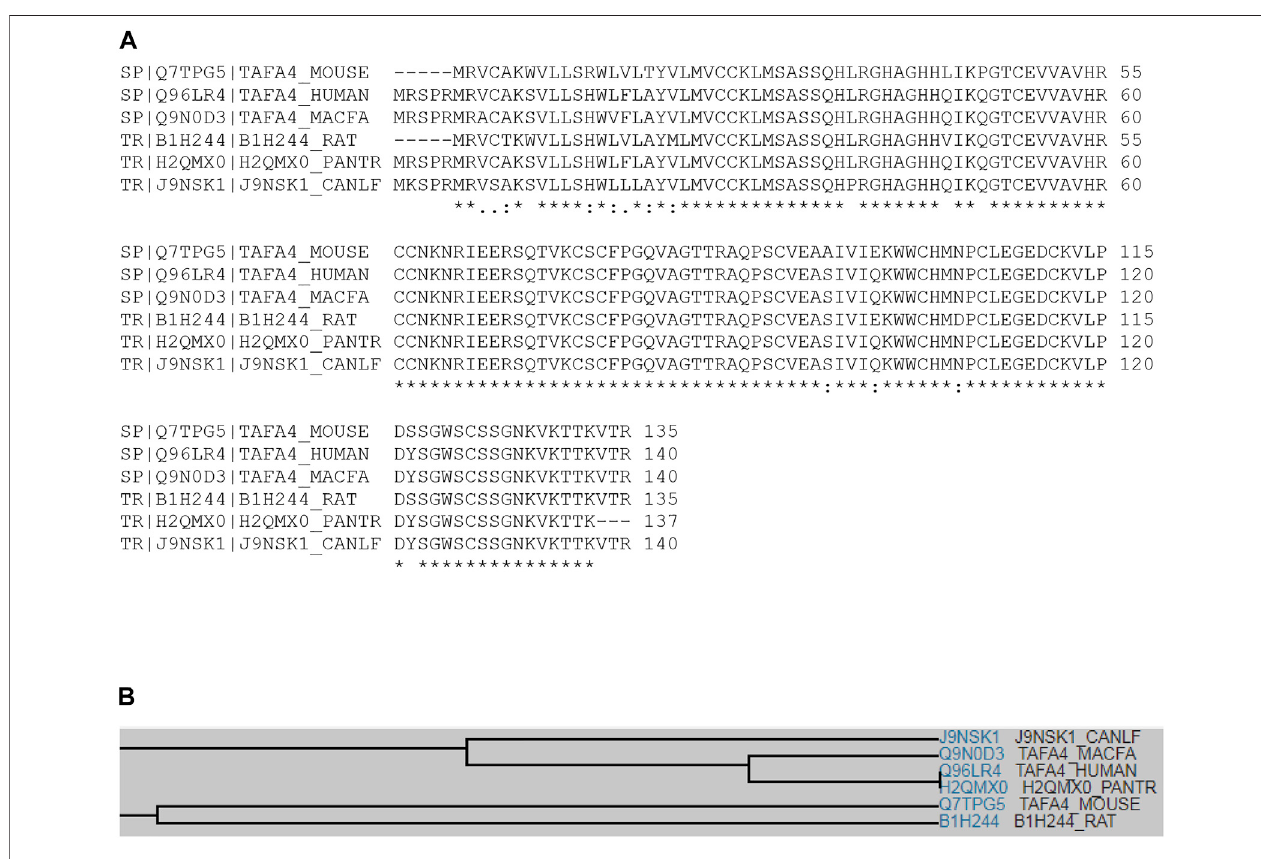
FIGURE 1 | Multiple sequence alignment of TAFA4 in various species. (A) Multiple sequence alignment analyses show that TAFA4 shares sequence identity and similaritywithTAFA4homologuesamongvariousspeciesincludinghuman,mouse,cynomolgusmonkey,rat,chimpanzee,anddog(https://www.uniprot.org/align). (B) A family tree of TAFA4 homologue proteins is